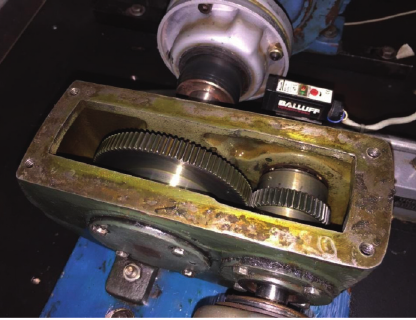
Figure 5: Gear pair.